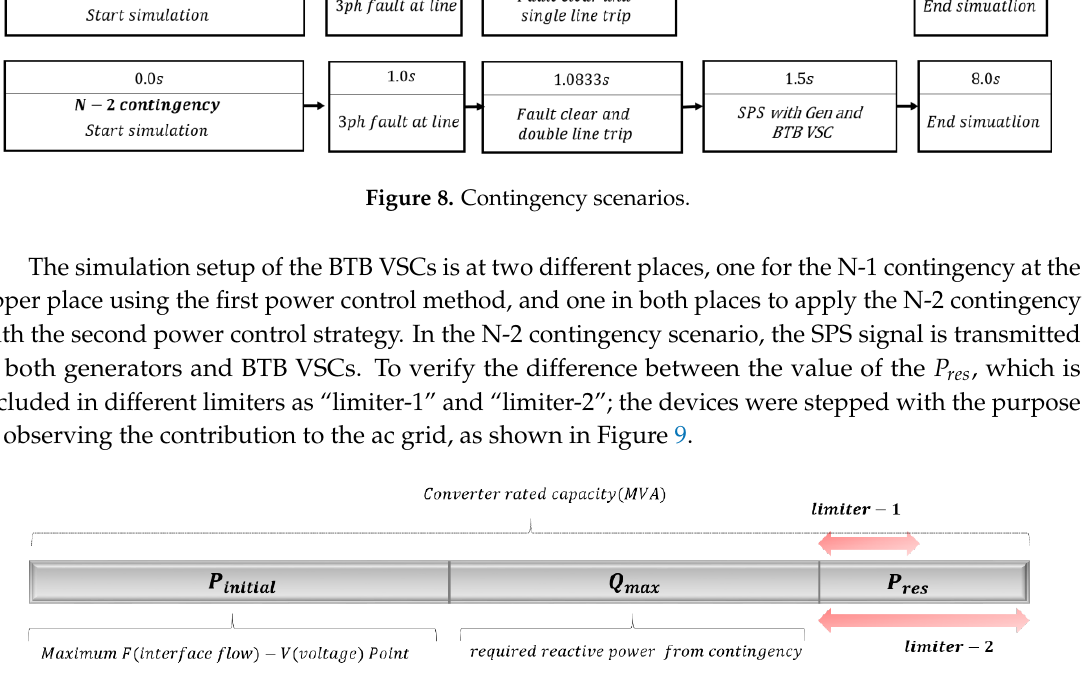
Figure 9. The limiter configuration in simulation study.